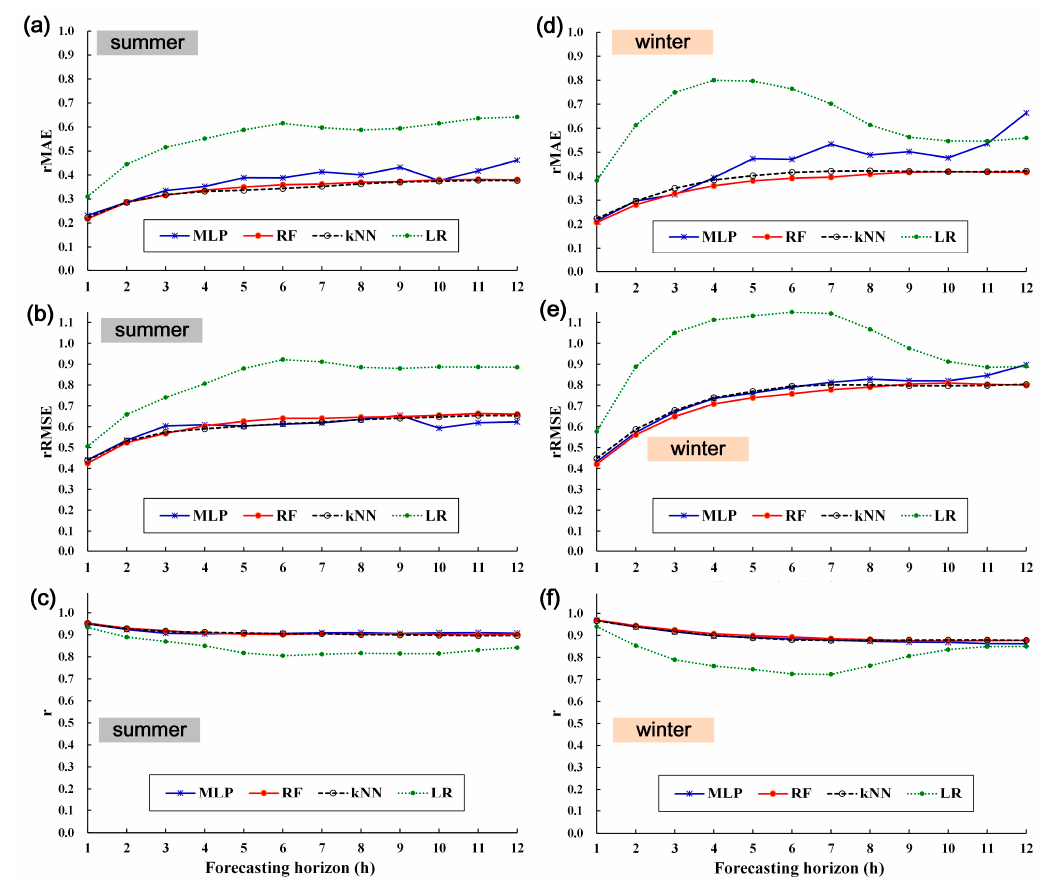
Figure 10. Performance of all models over a 12-h forecast horizon: ( a – c ) in summer, and ( d – f ) in